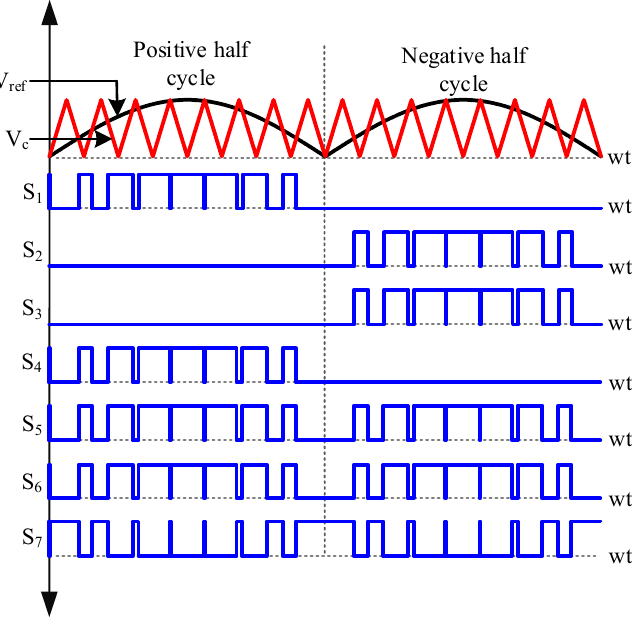
Figure 4. Gate-driving pulses for the proposed transformer-less inverter.